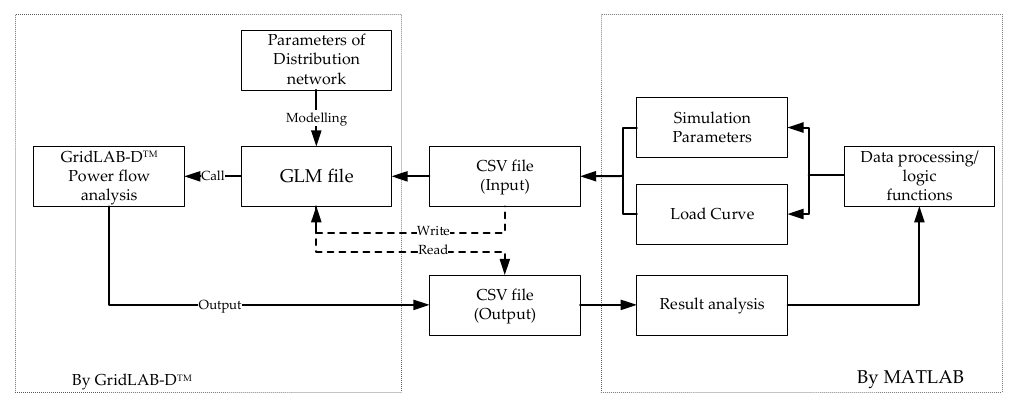
Figure 6. Co-simulation by GridLAB-D TM and MATLAB.